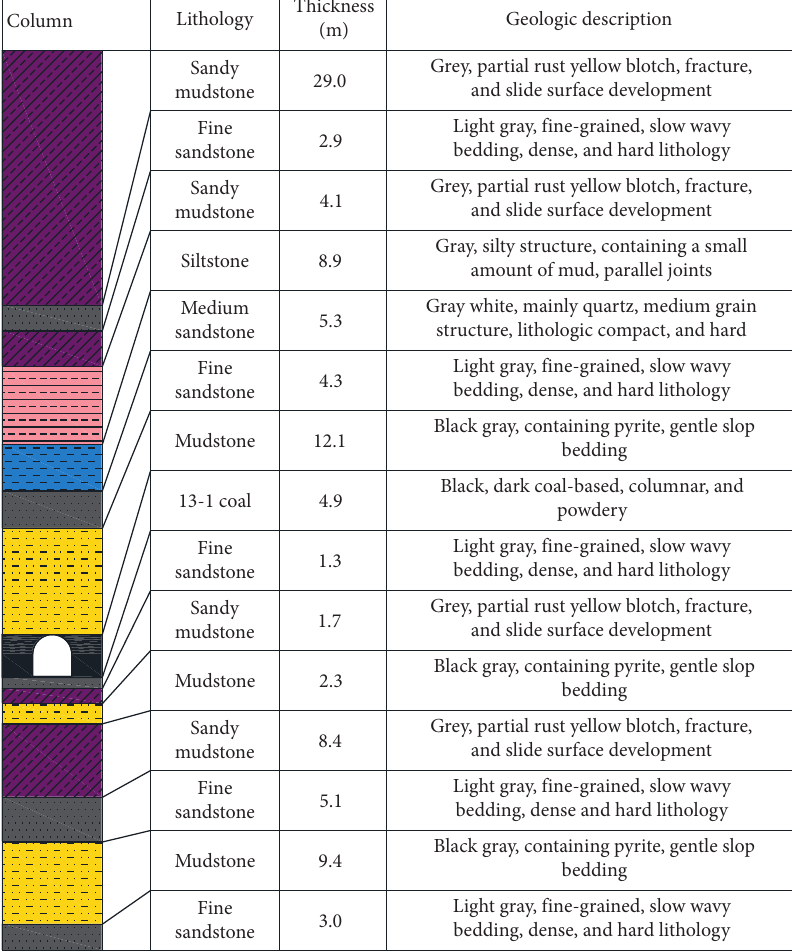
Figure 3: Geological structure at the mine